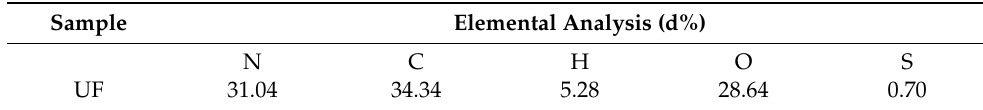
Table 1. Elemental analysis of UF.